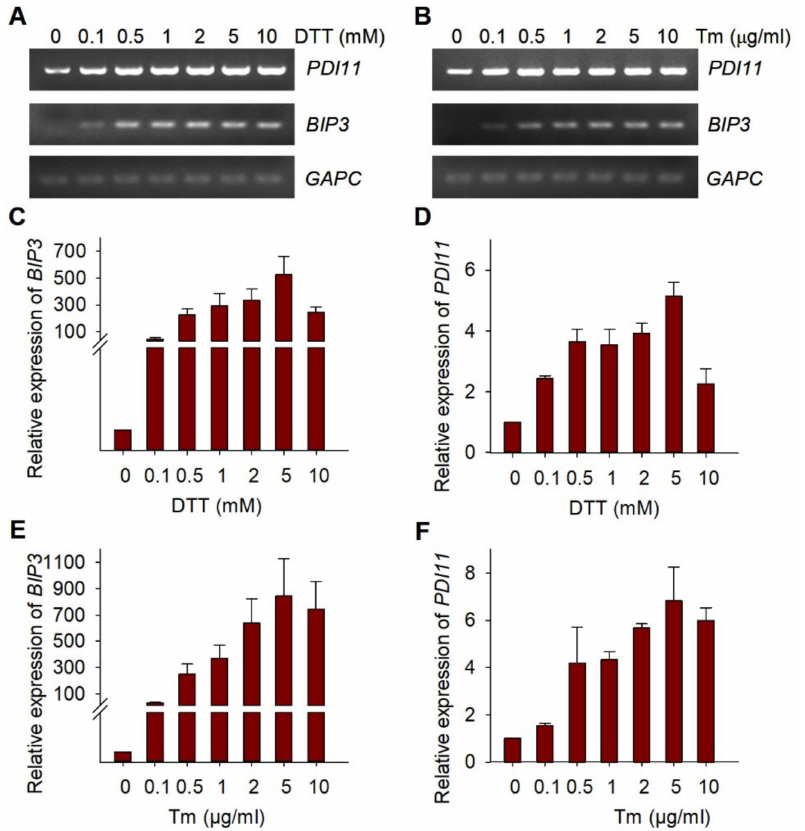
Figure 3. Expression level of AtPDI11 under DTT/Tm treatment of the different